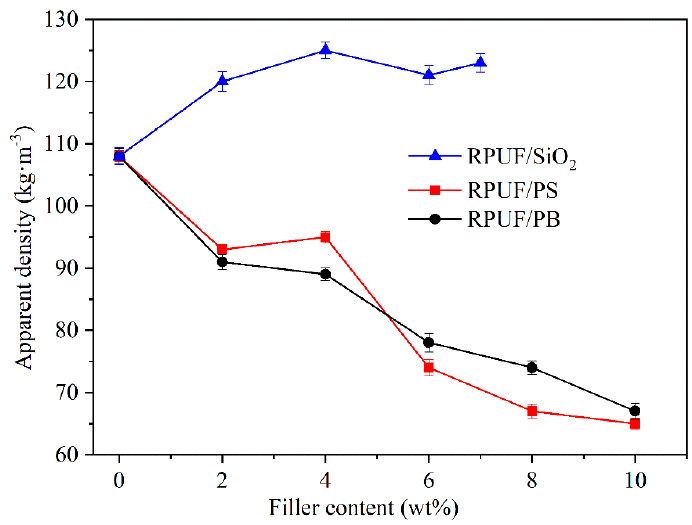
Figure 1. The apparent density of prepared composite RPUFs.